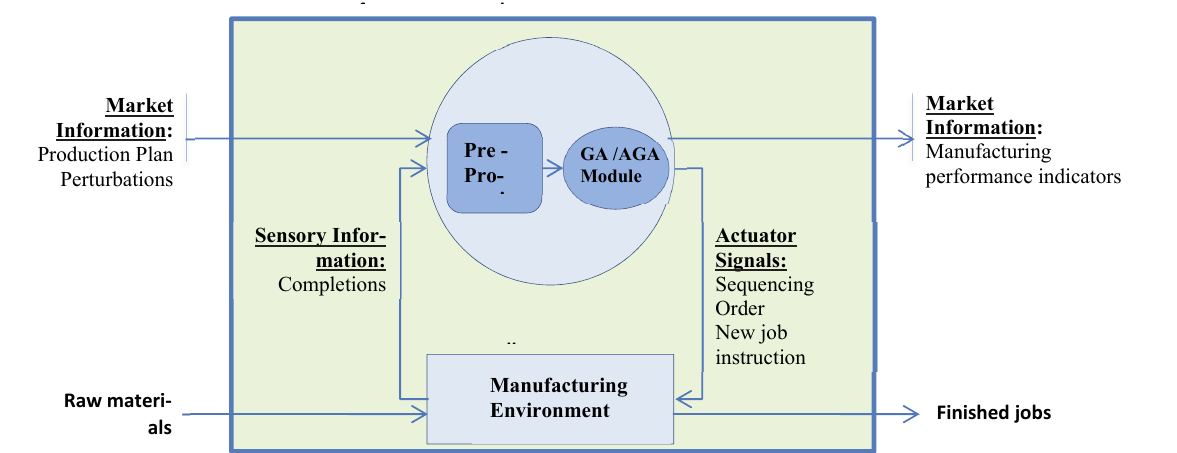
Fig. 1. Architecture of the proposed manufacturing control